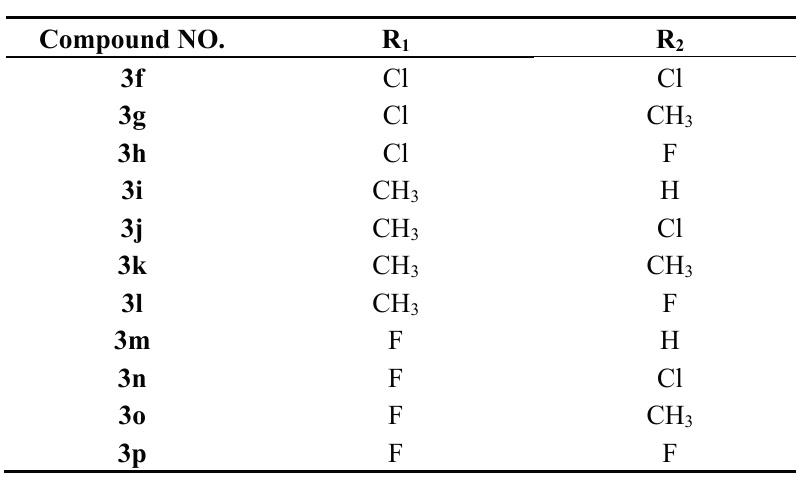
Figure 3. The structure of compounds 3a – 3p .